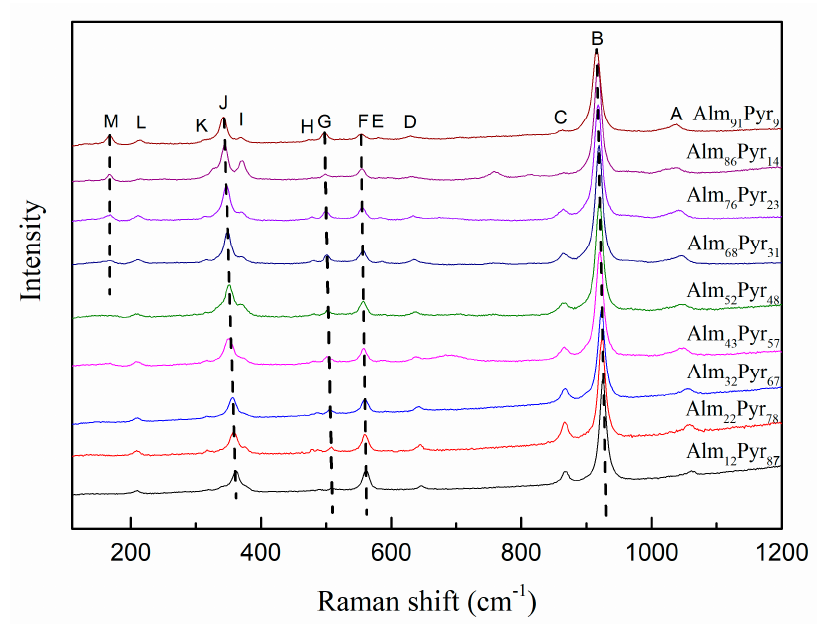
Figure 9. Raman spectra of garnets along Alm-Pyr binary. The marked M peaks represent the newly appearing Raman modes (translational modes of X-cations) for Alm-rich garnets.